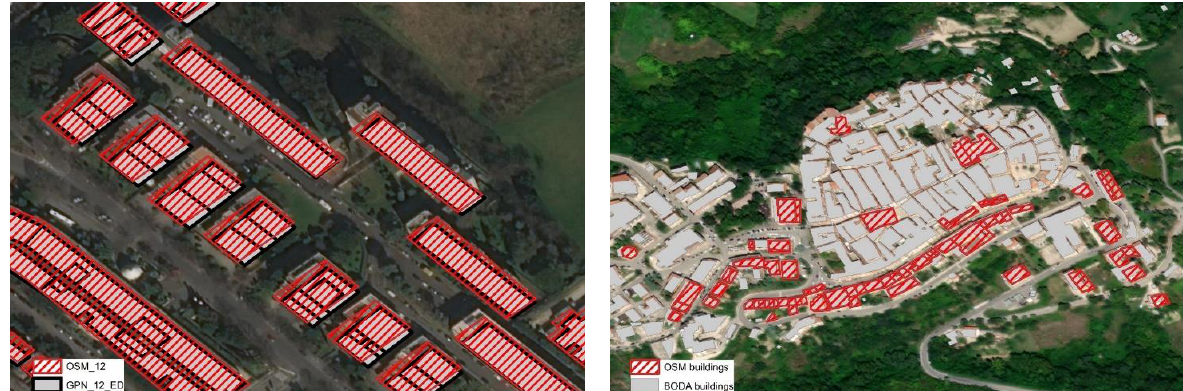
Figure 3. ( Left ) A visual example of the comparison of building data derived from the National Geo- Portal (GPN_12_ED) and the OSM database (OSM_12) in a strictly urban location of Rome, Central Italy (red and black indicate the building polygons identified through OSM and BODA, respectively); the full coverage of OSM with respect to the BODA archive is documented here. ( Right ) Spatial overlap of the content of OSM and BODA archives: an example from Frosolone, a rural municipality in Molise, Southern Italy; the partial coverage of OSM with respect to BODA is documented here.